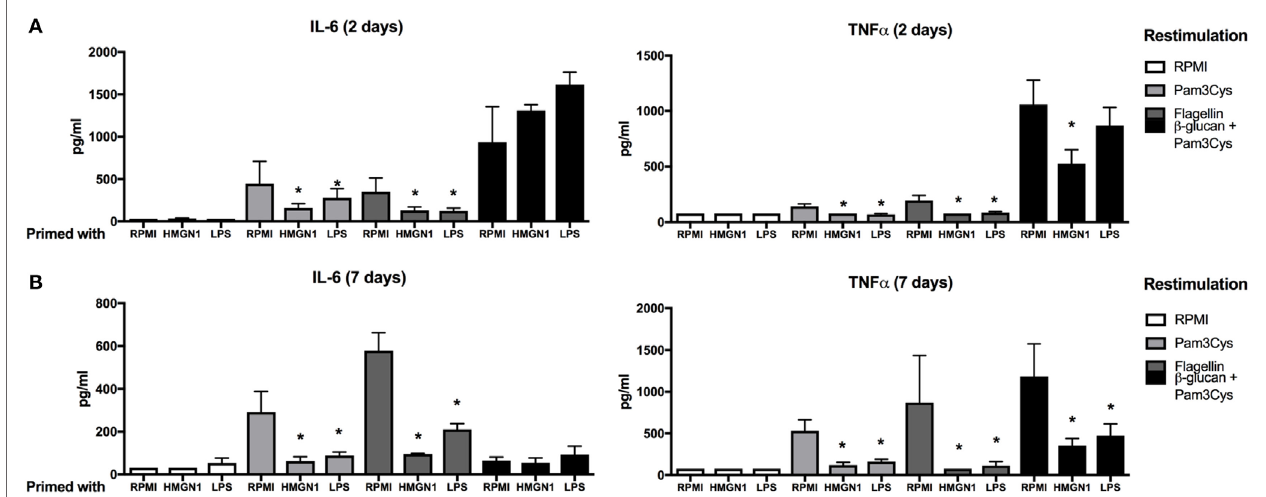
FigUre 3 | High-mobility group nucleosome-binding protein 1 (HMGN1) immunotolerance is not specific for TLR4 ligands. Human peripheral blood mononuclear cells were primed with recombinant HMGN1 or lipopolysaccharide (LPS) for 24 h and then washed with PBS. The cells were further rested in RPMI containing 10% serum for (a) 24 h or (B) 7 days then stimulated with Pam3Cys, flagellin, β -glucan, or RPMI, respectively, for additional 24 h and supernatant were harvested. The IL-6 and TNF- α levels were determined by ELISA ( n = 4–8 * p < 0.05 vs RPMI control within each group of